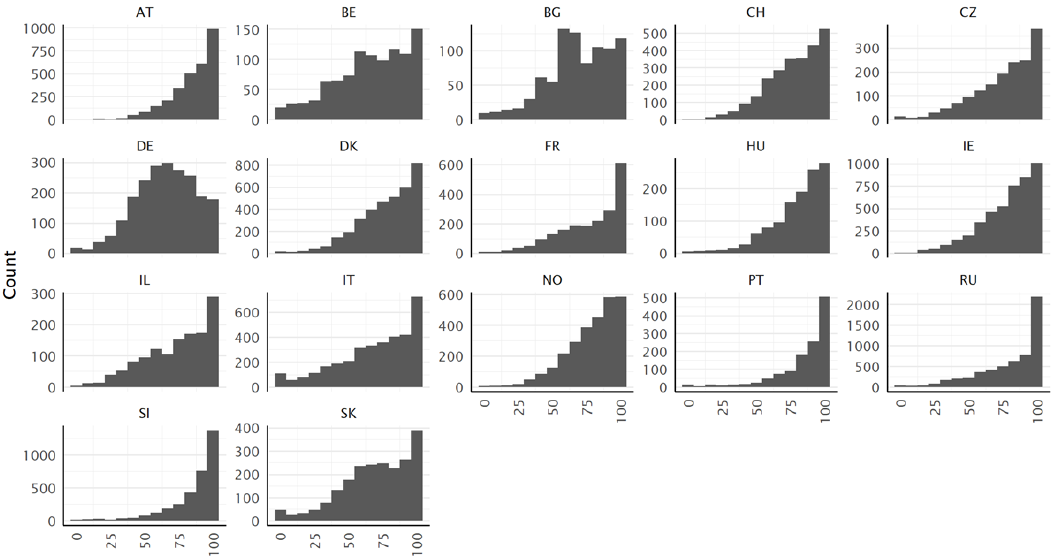
Figure 2. Histograms of the HLS 19 -Q12 scores (type D), for all countries.